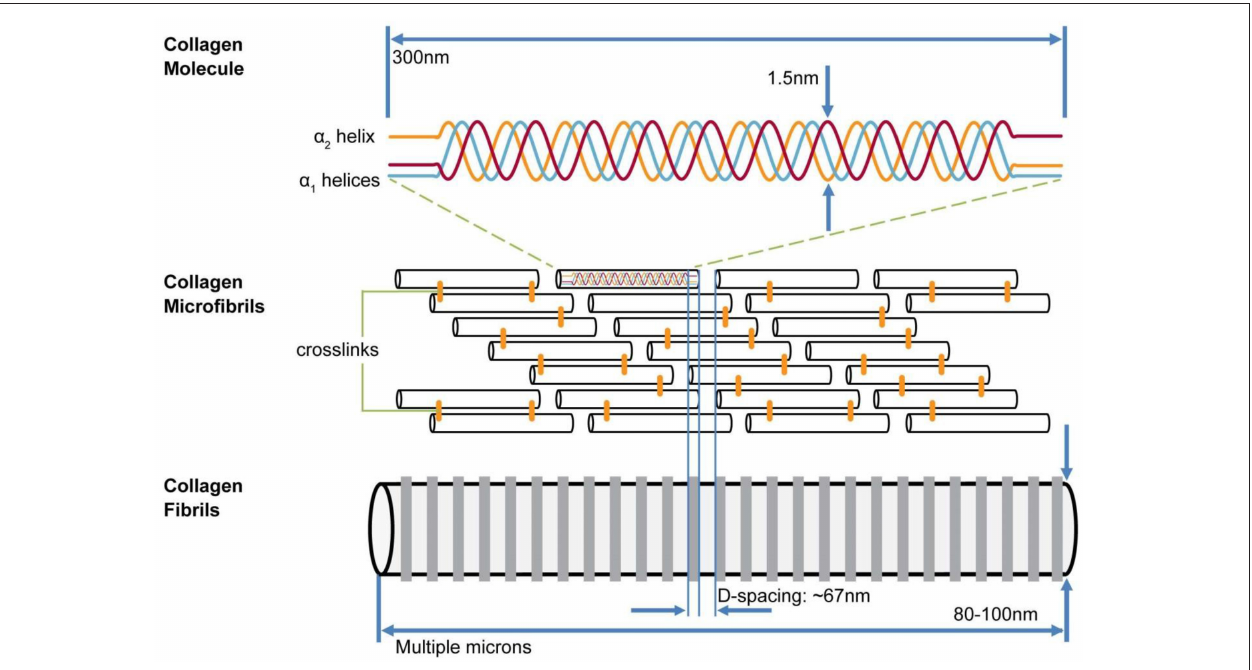
FIGURE 1 | Model of hierarchical structure of collagen fibrils. Three helical (two α 1 , one α 2 ) collagen molecules form a triple helix 300 nm long; these are assembled into a fibril containing a staggered array of helices with 40 nm gap between C and N termini of collinear helices. Gaps are aligned across width of collagen fibrils. Alongside each 40 nm wide “gap zone” (white) is a zone 27 nm wide in which no gaps exist (from Canelón and Wallace [